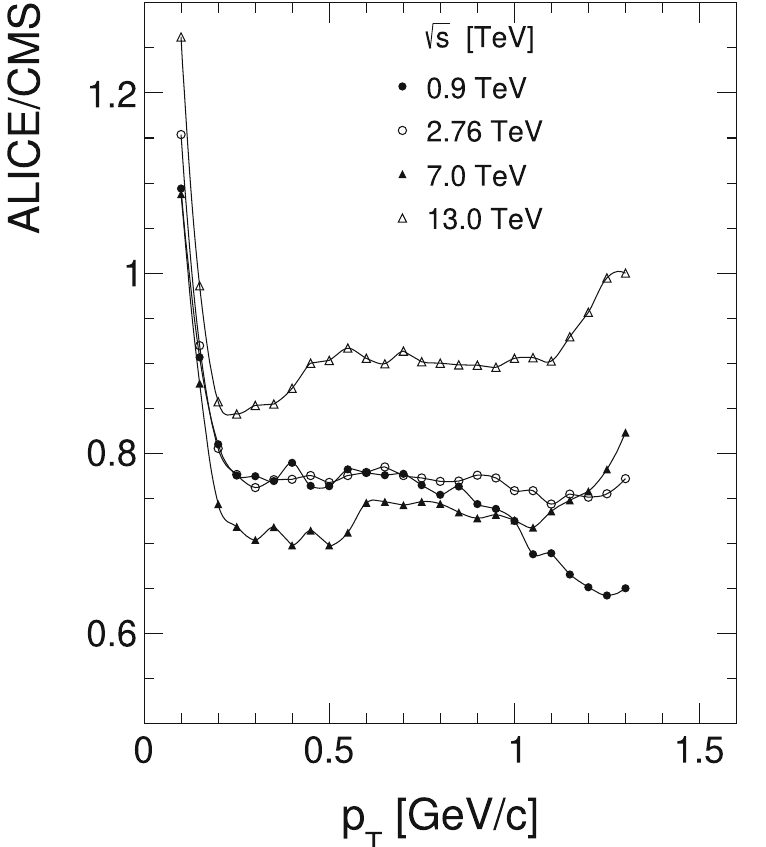
√ s = 0.9 TeV, 2.76 TeV, 7 TeV and 13 TeV as a function of p T